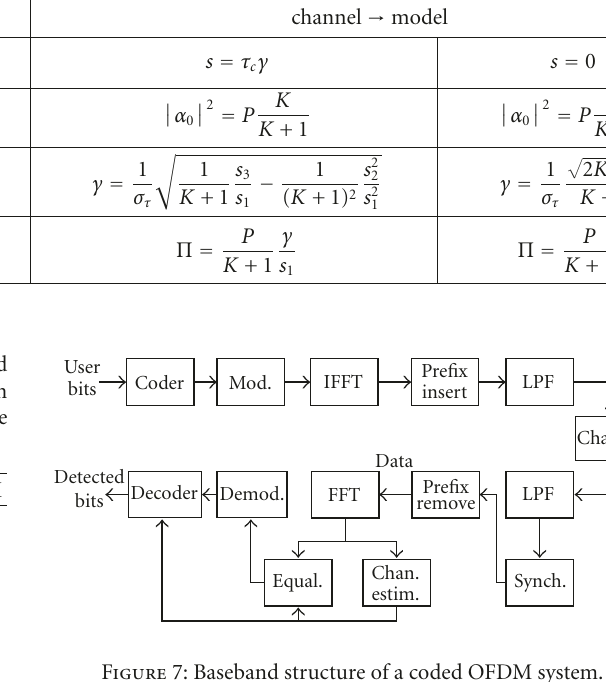
Table 4: Relation between model and channel parameters when the shape parameter s is known (see [36]). model → channel channel → model